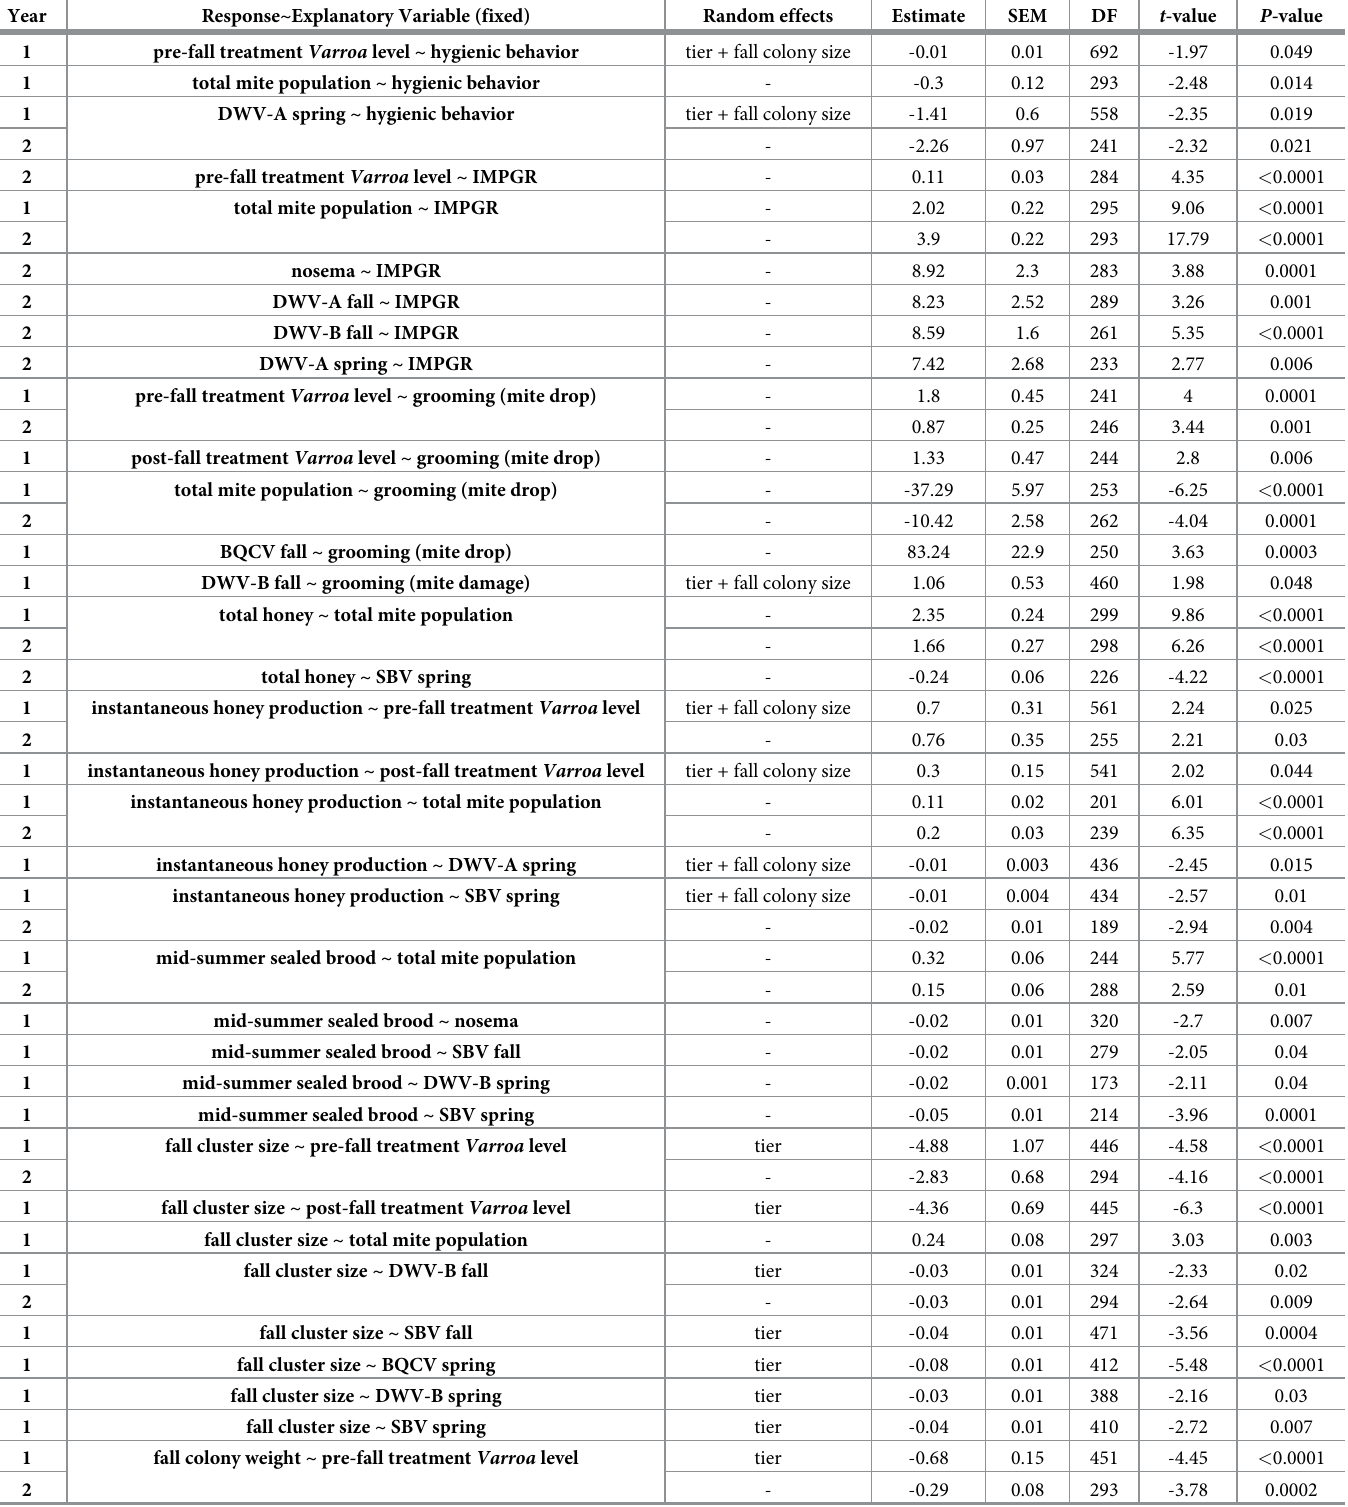
Table 4. Linear regression model summaries for the 2016–17 (year 1) and 2017–18 (year 2)